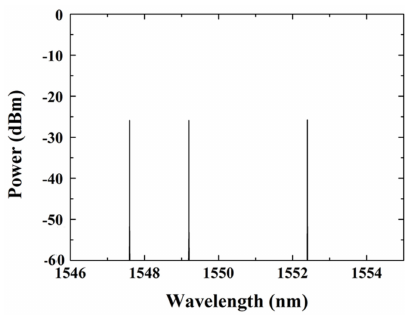
Figure 11. The spectrum of the odd channels at the output port 2 with the drop process.